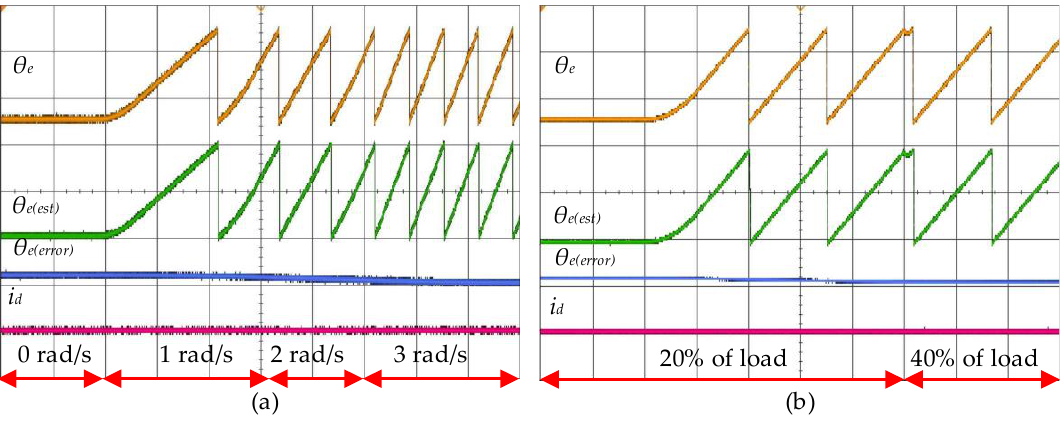
Figure 10. Experimental results using MRAS. ( a ) Measured and estimated rotor position and rotor position at 20% of full load. ( b ) Measured and estimated rotor position and rotor position at 1 rad/s. (Scale: ω e , ω e(est) : 3 rad/div; ω e(error) : 5 rad/div; i q :2.5 A/div; θ e , θ e(est) : 150°/div; θ e( error ) : 30°/div; i d : 1 A/div).